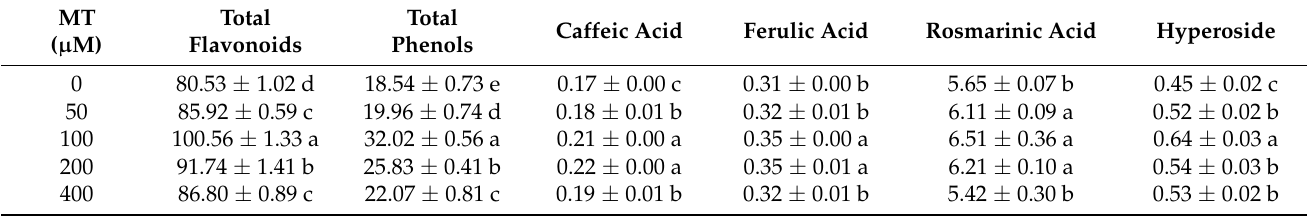
Table 3. Effects of different concentrations of MT on the contents of total flavonoids, total phenolics, caffeic acid, ferulic acid, rosmarinic acid, and hyperoside in P. vulgaris